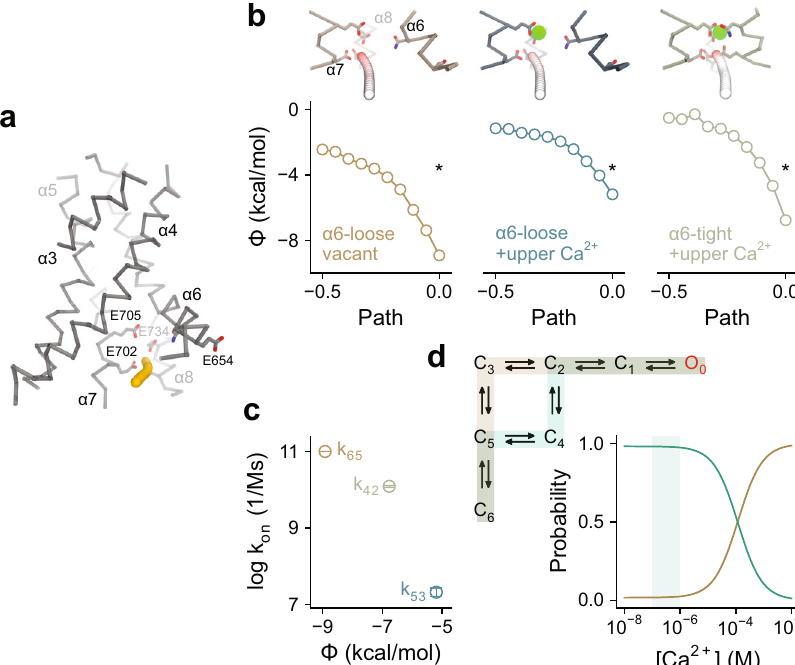
Fig. 2 Electrostatic pro fi les of the Ca 2 + binding site and their effect on the activation sequence. a Pore region of a TMEM16A subunit in the Ca 2 + -free conformation (PDB: 5OYG) in C α representation. Ca 2 + -binding residues are shown as sticks. Yellow spheres indicate the points at which the electrostatic potential is plotted. b Electrostatic potential ( Φ ) along the path for the indicated channel con fi gurations (insets). Left, α 6-loose conformation in the absence of Ca 2 + . Center, α 6-loose conformation with the upper Ca 2 + binding site occupied. Right, α 6-tight conformation with the upper Ca 2 + binding site occupied. Green spheres correspond to bound Ca 2 + ions and small spheres display the trajectory at which the electrostatic potential was plotted (colors indicate the local electrostatic potential). The data point at zero (*) on the x -axis corresponds to the position at the vacant lower Ca 2 + binding site. c Relationship between the calculated electrostatic potential and the estimated k on for Ca 2 + binding (displayed in Fig. 1e). Errors are 95% con fi dence intervals. d Relative probability of the two possible activation sequences (top, highlighted in brown and green) as a function of Ca 2 + concentration (bottom), calculated using Eqs. 28 and 29 with the parameters estimated from Fig. 1. The shaded region corresponds to physiologically relevant intracellular Ca 2 +